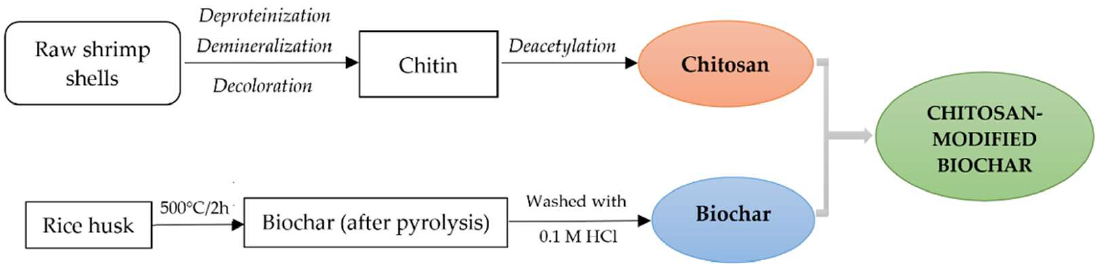
Figure 1. Schematic diagram of preparation process of chitosan-modified biochar.